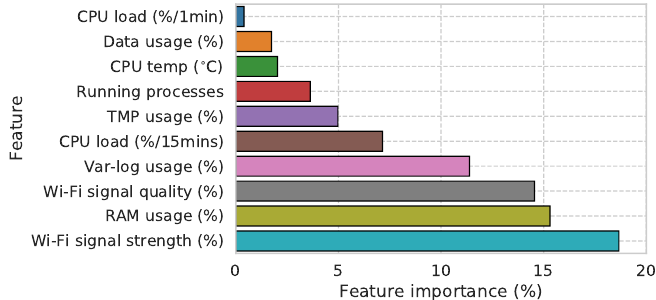
Figure 15. Feature importance’s of predictive model (total =